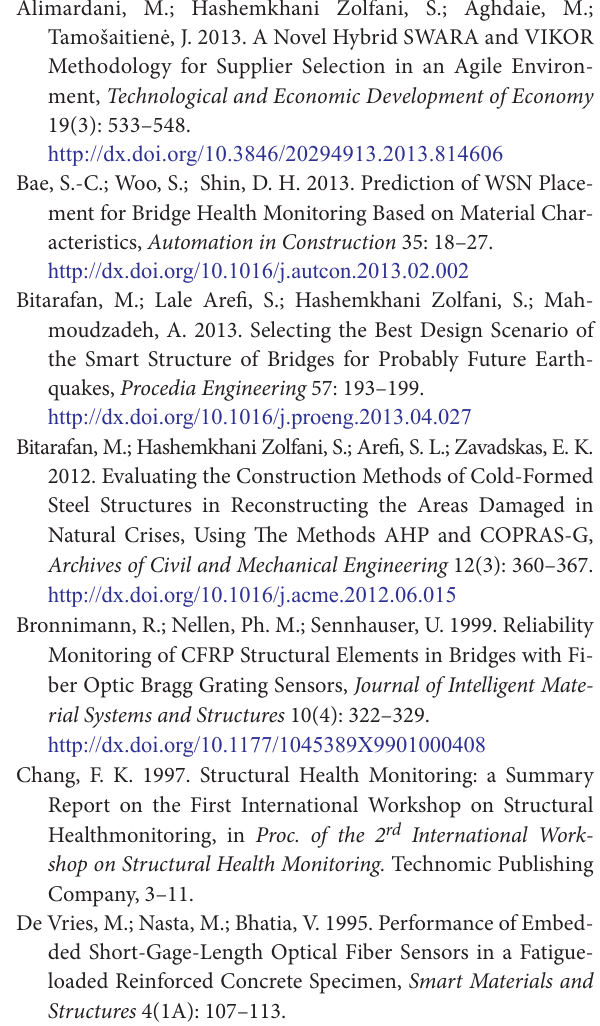
Table 7 presents judgment matrix and the final weight of each WASPAS weighted and normalized decision mak- ing matrix for multiplication part .